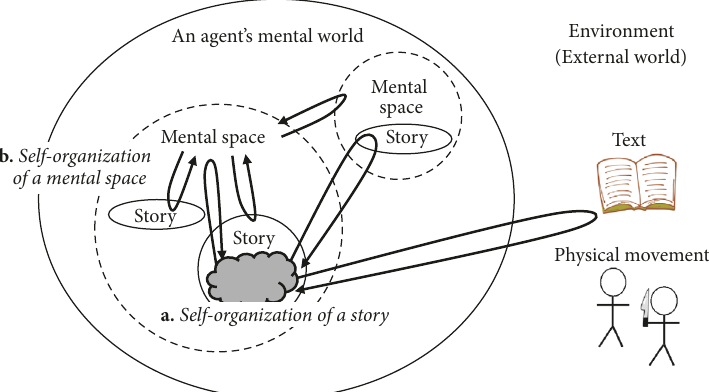
Figure 8: Powers of the self-organization in a mental world.